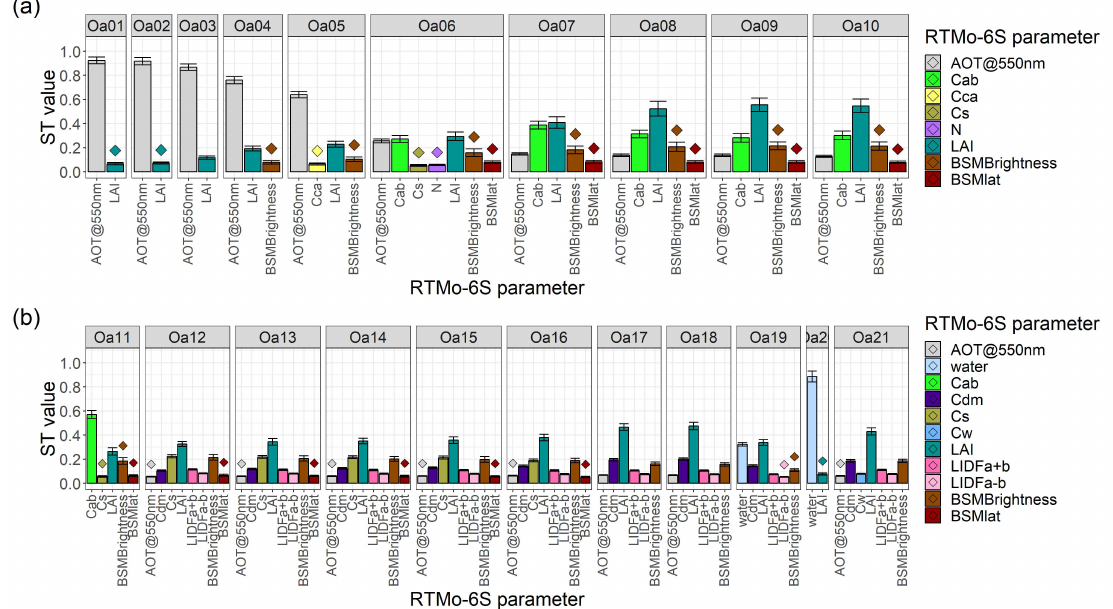
Figure 5. Significant total order sensitivity indices (ST > 0.05) for OLCI instrument. Parameters marked with diamonds had insignificant first order sensitivity index (S1 < 0.05) and reached significant ST through interactions. ( a )—visible domain, ( b )—near infrared domain. Definitions of parameters can be found in Table